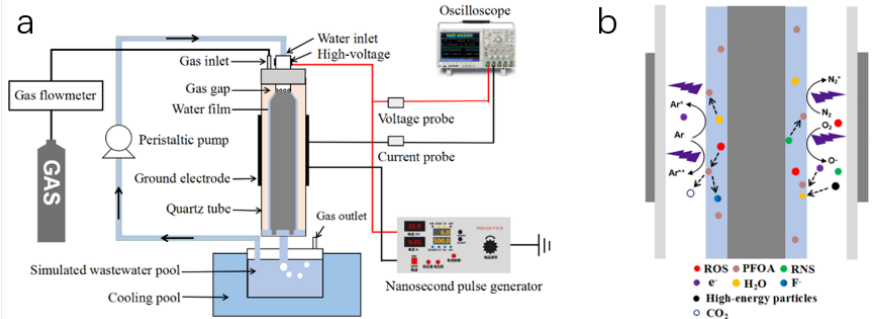
Figure 1. ( a )Schematic diagram of the SF-DBD system used in PFOA-polluted water treatment. ( b ) The reactor diagram used in PFOA simulated wastewater treatment.